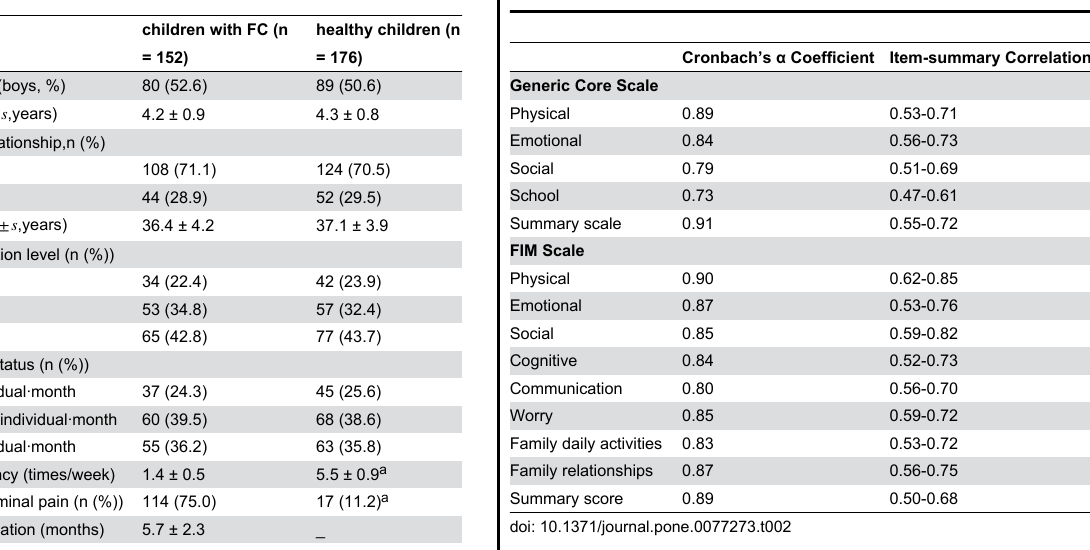
Table 1. Baseline characteristics of children with FC and healthy children.